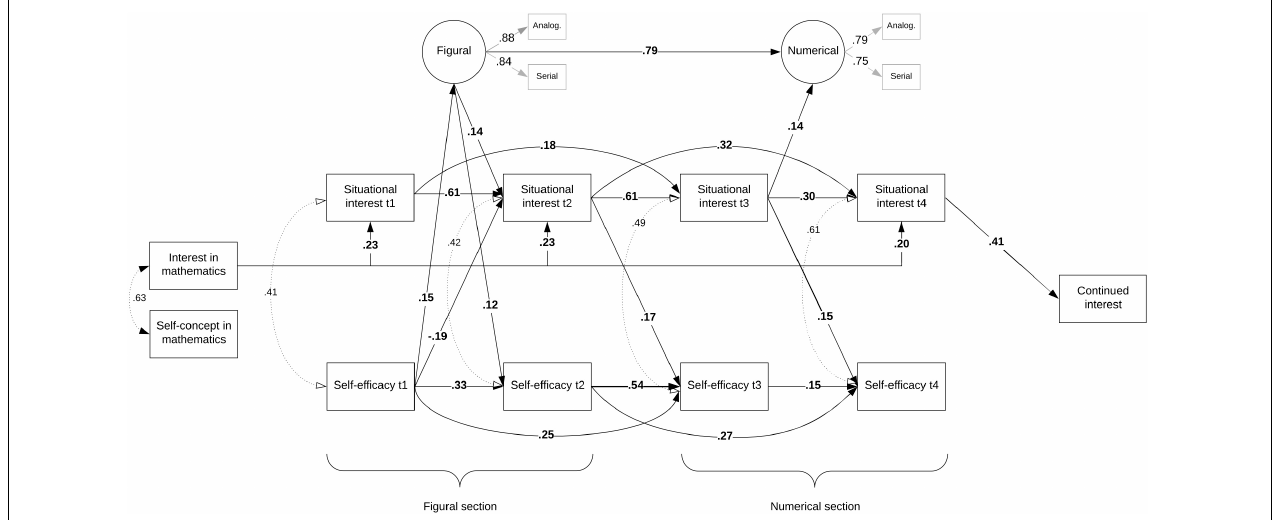
FIGURE 2 | Empirical SEM-model of cross-lagged reciprocal effects (only correlations and significant standardized direct effects at p < 0.05 are displayed). Note, that no gender effects were detected, due to which it is omitted from the model for the purpose of